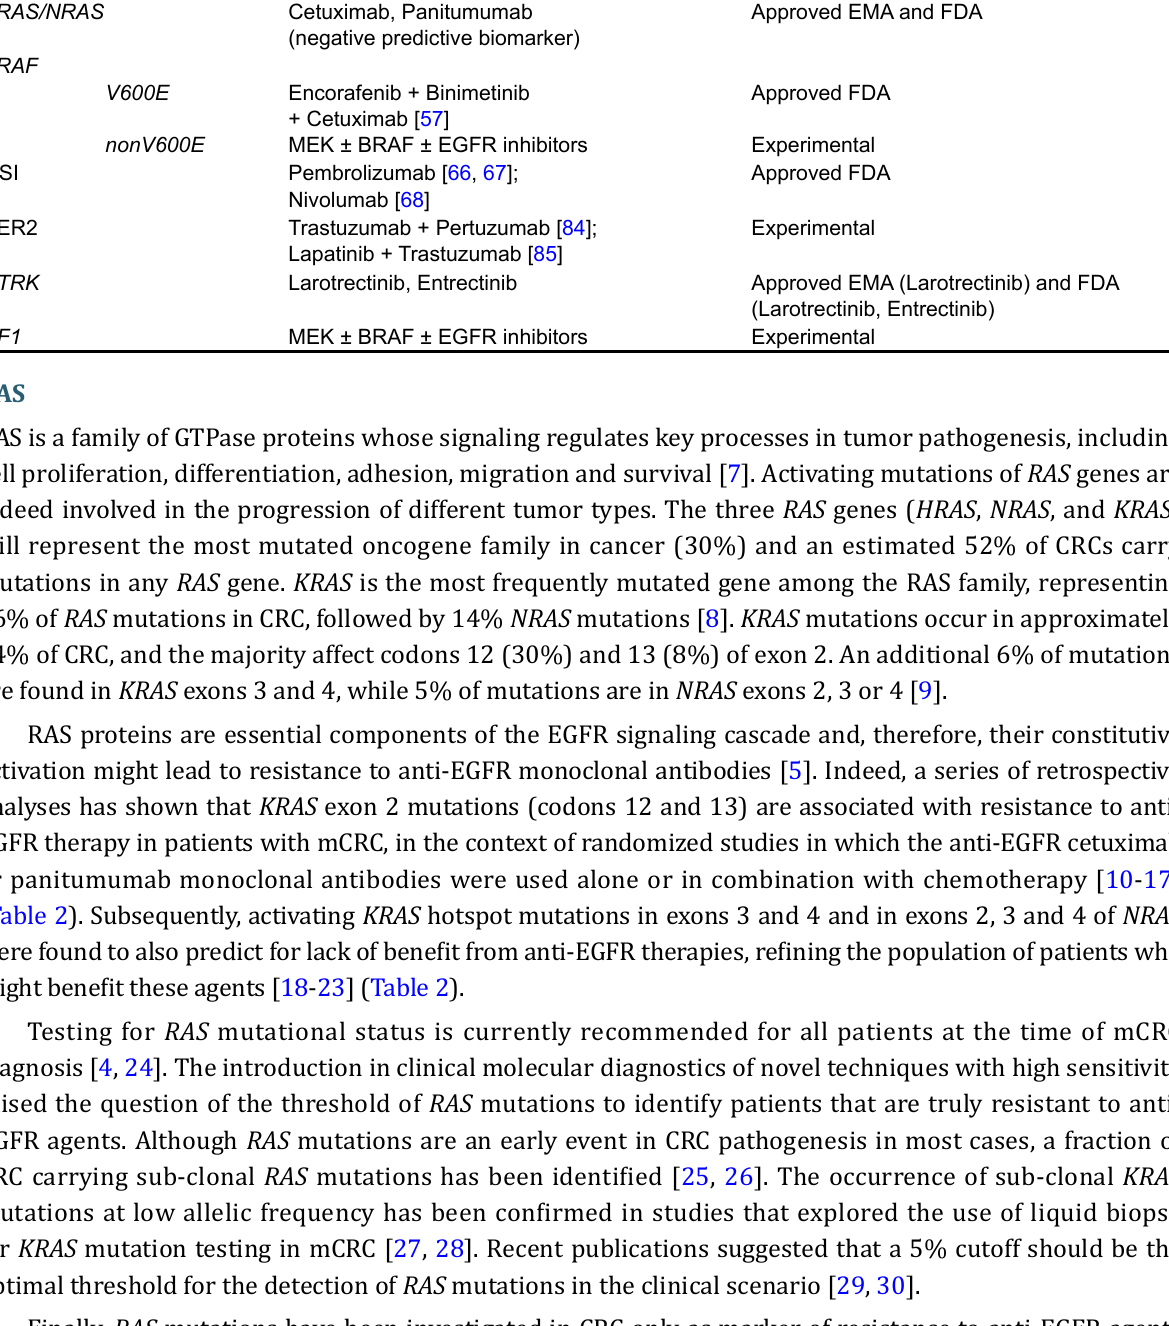
Table 1. Summary of current and emerging molecular biomarkers associated with targeted therapies